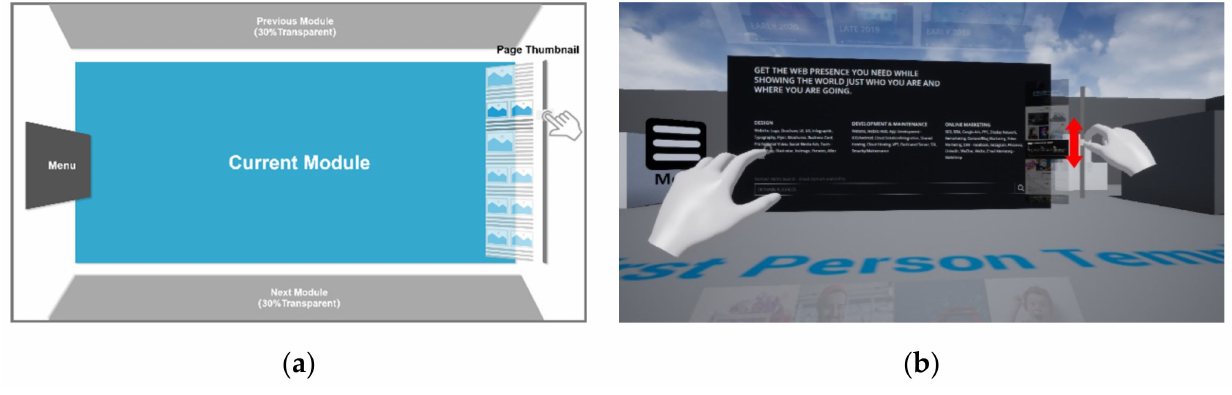
Figure 9. Scrollbar design: ( a ) Scrolling concept [21]; ( b ) Developing screenshot (scrolling the bar).